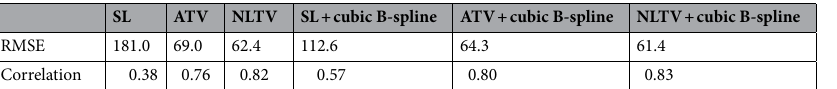
Table 3. Quantitative comparisons using two metrics in the high resolution reconstruction image generated by six FDK algorithms with low-dose projection data of the Catphan503 phantom.